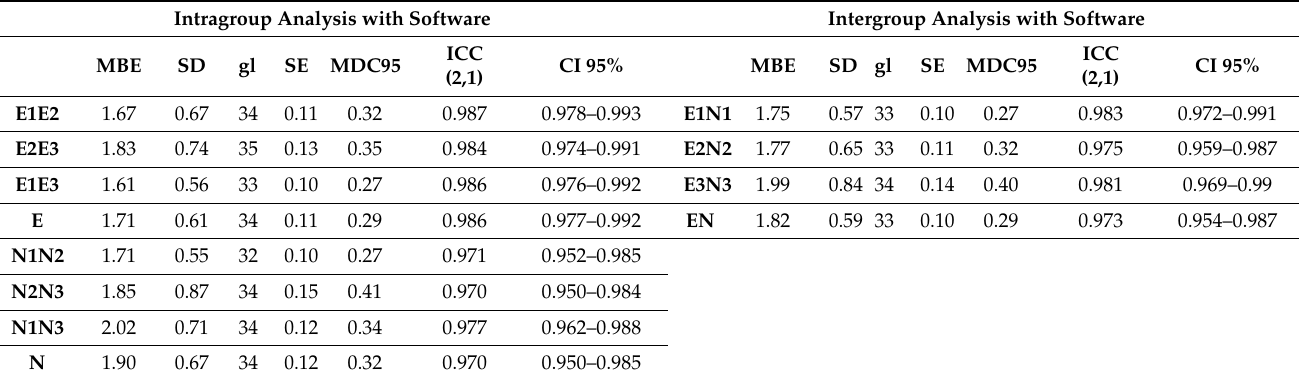
Figure 2. The 95% confidence intervals of the intra-group MBEs. The letter E identifies the measurements obtained by the group of expert observers. E1, E2, and E3 represent the measurements obtained by the group of expert observers in the first, second, and third rounds of measurements, respectively. The letter N identifies the measurements obtained by the group of novice observers. N1, N2, and N3 represent the measurements obtained by the group of novice observers in the first, second, and third rounds of measurements, respectively. The intervals for MBE in the error distribution of E1E2 (between the first and second round of expert measurements), E2E3, E1E3, and E (interval for the intra-group MBE when considering the three batches of expert measurements) are shown. In the same way, the intervals for the different measurement runs of the novice group are shown. Both distributions are shown for the data obtained both with the software and manually, where E and N are the intra-group error distributions in the three measurement runs of the expert (E) and novice (N) groups. In green, the errors of the intra-group measurements of the Expert group between measurement rounds 1 and 2, 2 and 3 and 1 and 3. In blue, the errors of the intra-group measurements of the Novice group between measurement rounds 1 and 2, 2 and 3 and 1 and 3. In black, the errors in the measurements of the Expert and Novice groups in all three tests. Table 1. The intra- and inter-group validity and reliability analysis with the software and man- ual